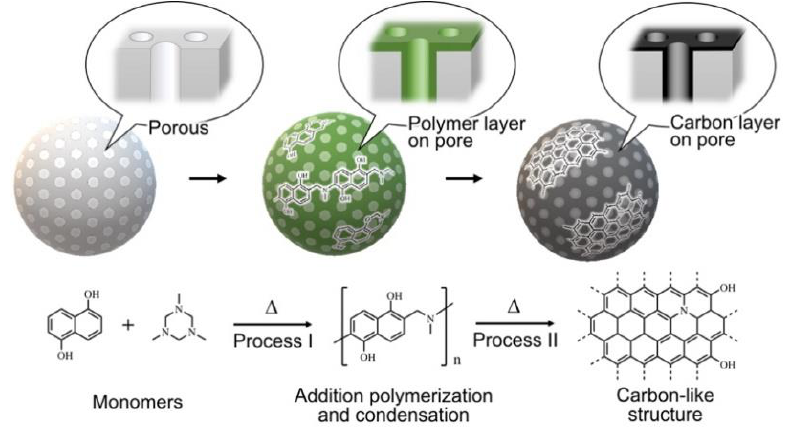
Figure 1. Schematic illustration of black layer-laminated porous silica through bottom-up carbon structure creation from 1,5-dihydroxynaphthalene (DHN) and 1,3,5-trimethyl-1,3,5-triazinane (TMTA), and its estimated reaction mechanism.